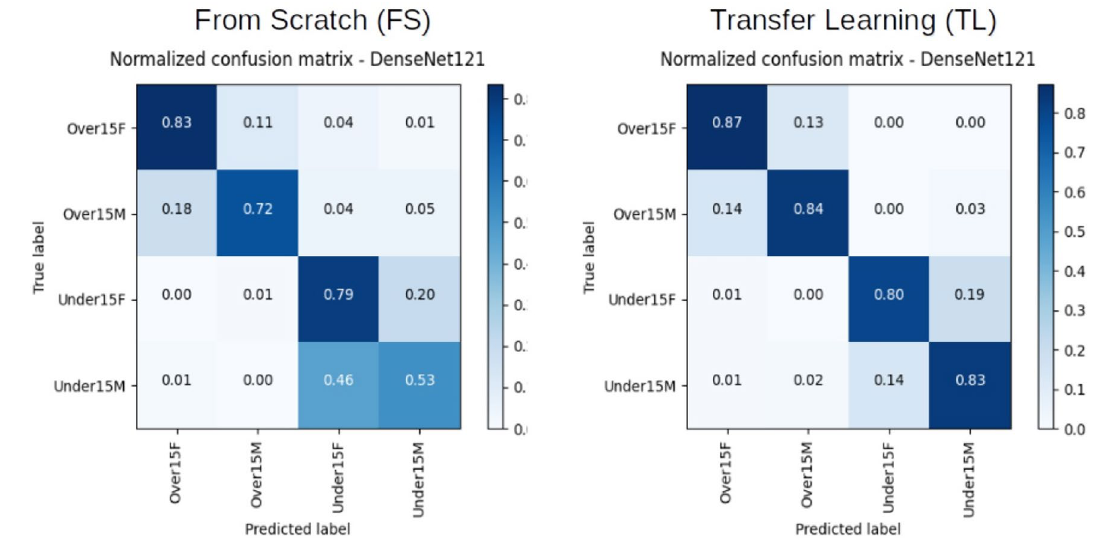
Figure 4. Normalized Confusion Matrix with the classification frequencies for each group set in the learning model. Outcomes presented for DenseNet121 using From Scratch (FS) and Transfer Learning (TL)